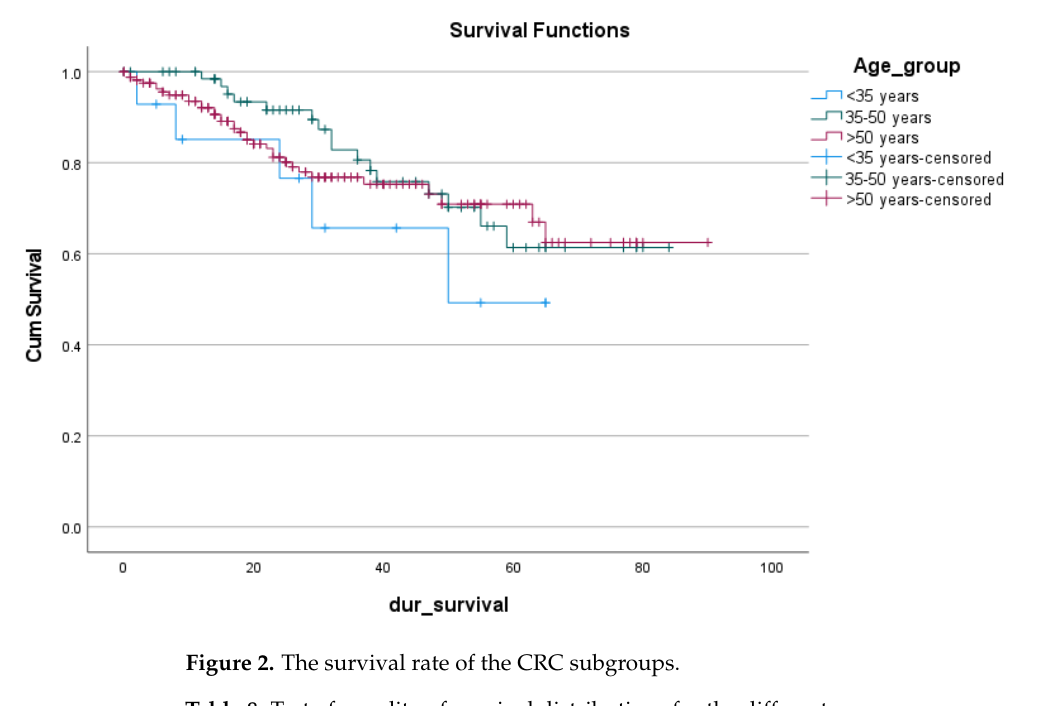
Table 8. Test of equality of survival distributions for the different age groups.